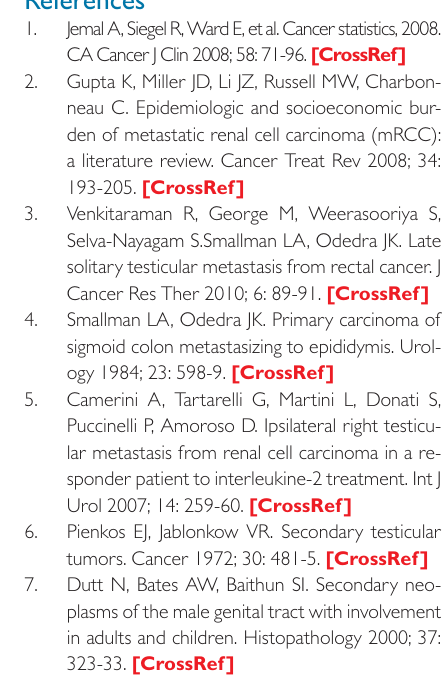
Figure 2. Infiltration of tumor cells consisting of clear cytoplasm in the medulla of the kidney (black arrows). intravascular tumor cell groups next to the distal and collecting ducts (white arrows), (magnification x4).